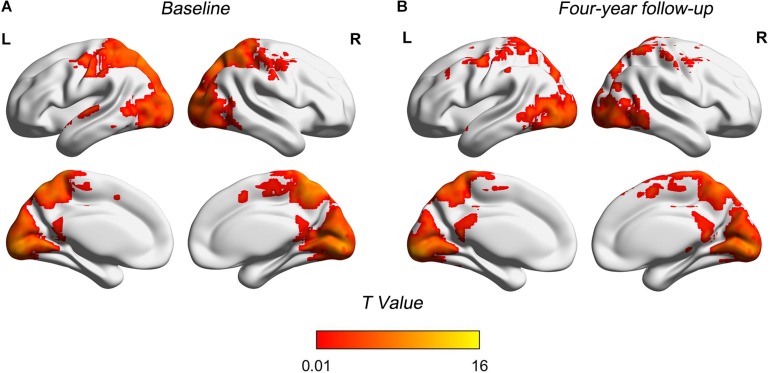
Spatial FCS patterns of two time points. (A) FCS patterns in baseline. (B) FCS patterns in 4-year follow-up. Brain regions showing higher FCS were mainly located in precuneus, calcarine, inferior occipital, and inferior temporal. FCS maps at two time points showed similar distribution patterns. FCS, functional connectivity strength; T, statistical value; L, left bran; R, right brain.